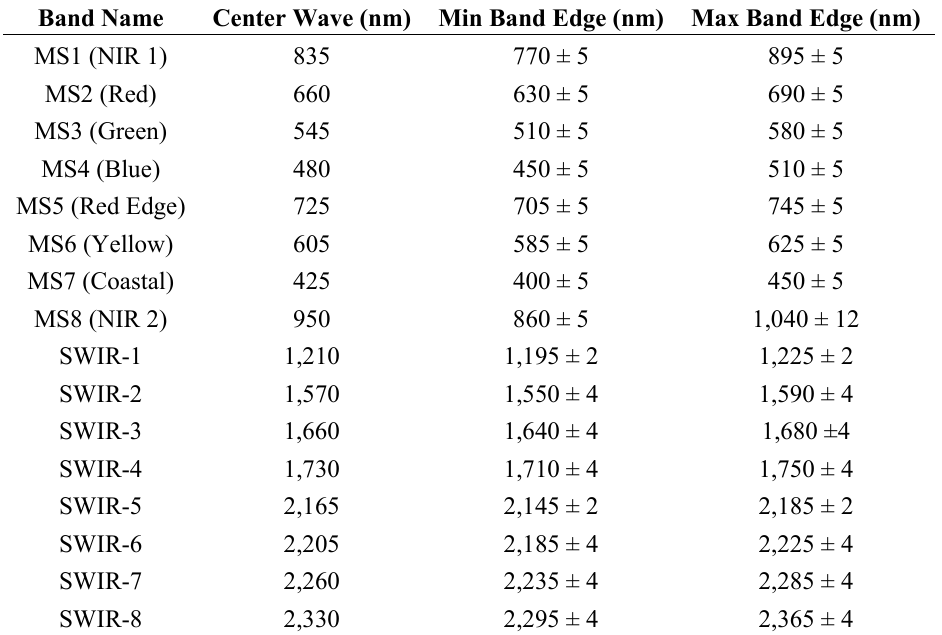
Table 1. The proposed Worldview-3 (WV-3) VNIR and SWIR Spectral Bands.